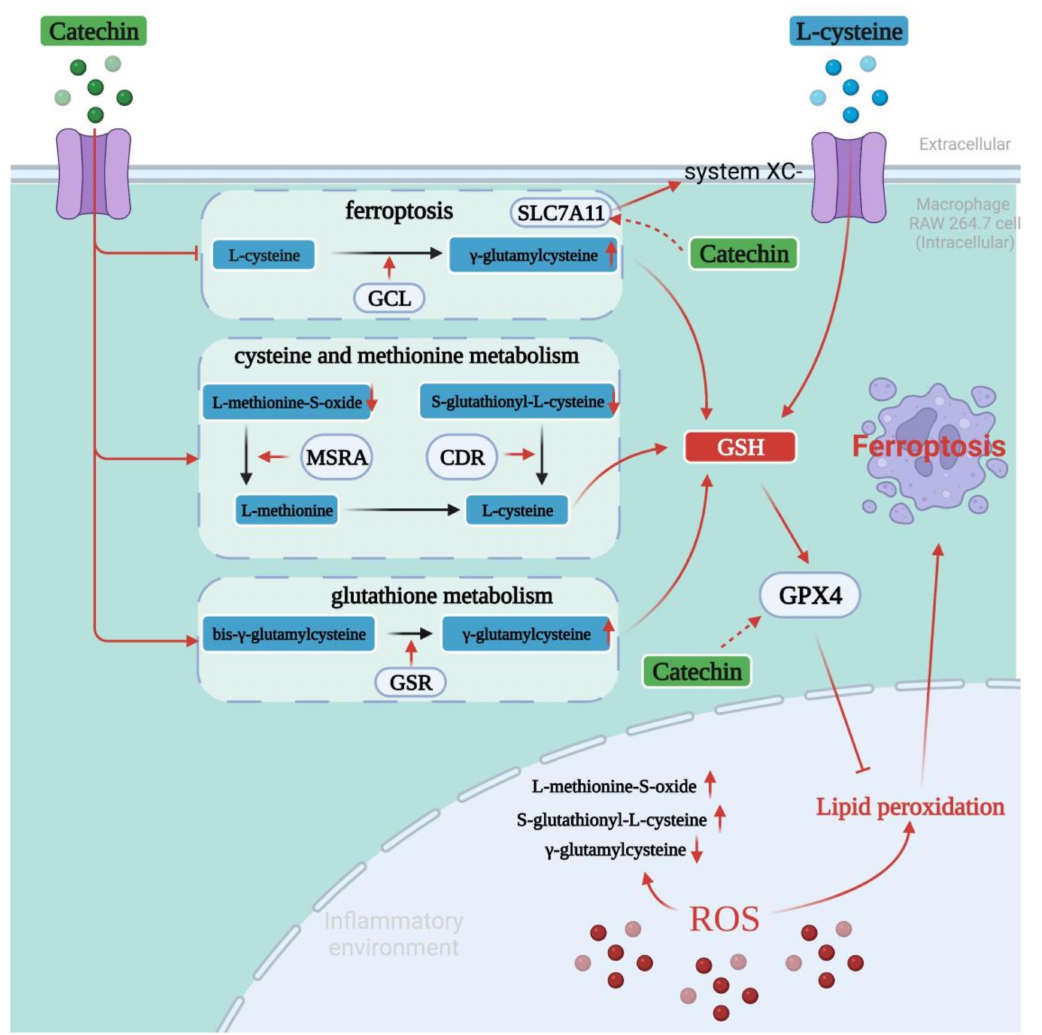
Figure 5. Hypothetical molecular mechanism of ferroptosis mediated anti-inflammatory process of catechin (created with https://app.biorender.com/ (accessed on 18 April 2022)). Lines with red arrowheads represent activation and lines with bars at the end denote